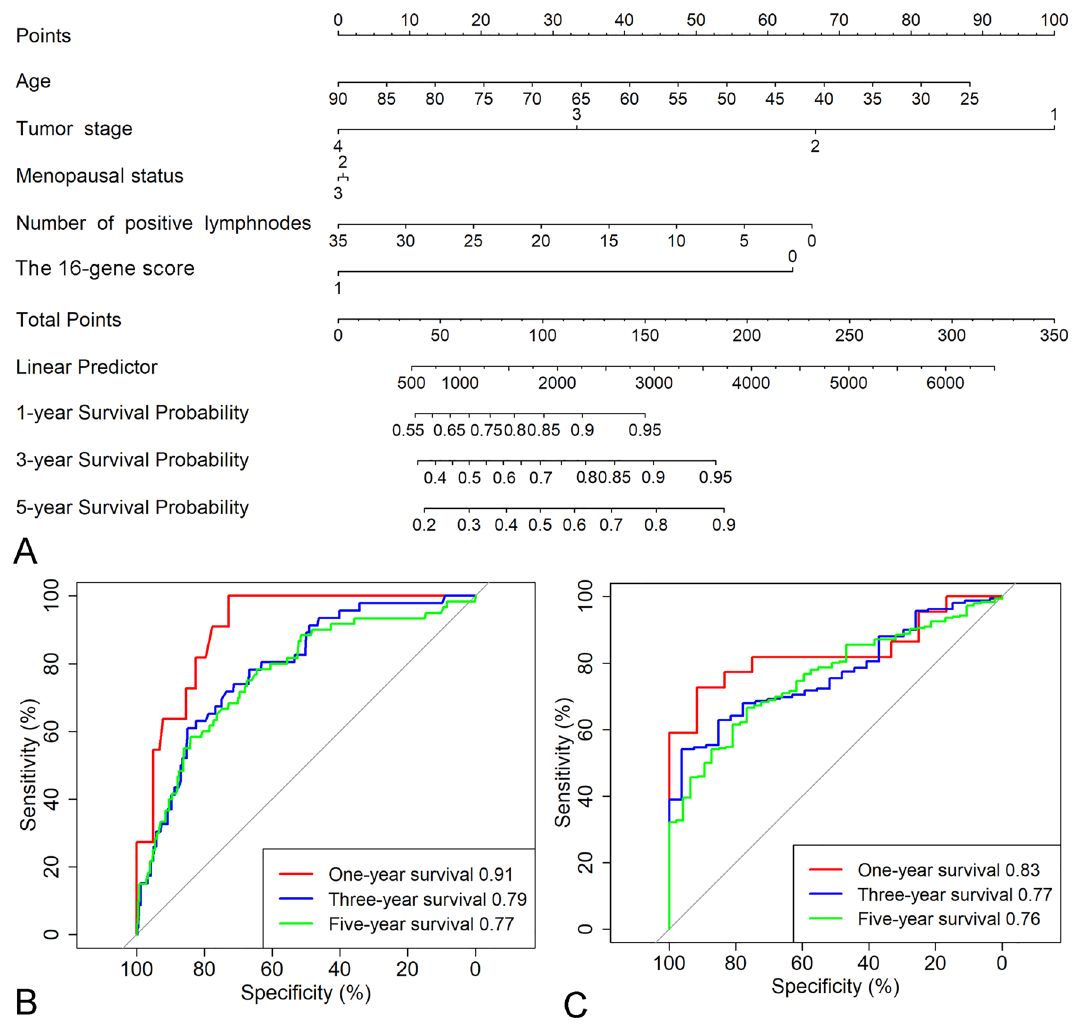
Figure 5. The 16-gene nomogram to predict the risk of disease in patients with BRCA. ( A ) mRNA nomogram to predict disease ‐ free survival. 1, 2, 3 for the menopausal status denote pre-menopause, peri-menopause and post-menopause respectively. 0 and 1 for the 16-gene score represent high and low 16-gene scores respectively which were divided by the median 16-gene score. ( B ) The ROC plot for the nomogram in predicting of 1-year, 3-year and 5-year survival in the TCGA cohort. ( C ) The ROC plot for the nomogram in predicting of 1-year, 3-year and 5-year survival in the METABRIC